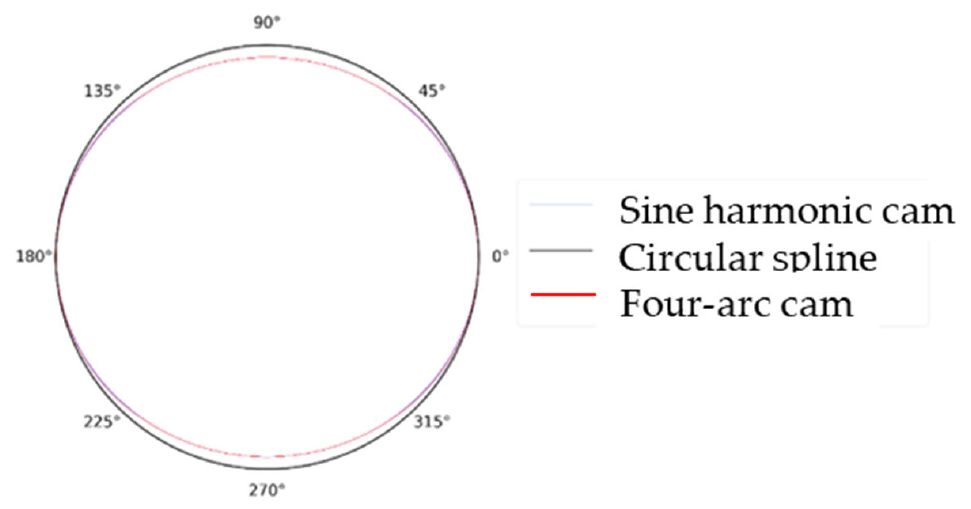
Figure 5. Comparison of two types of cams.